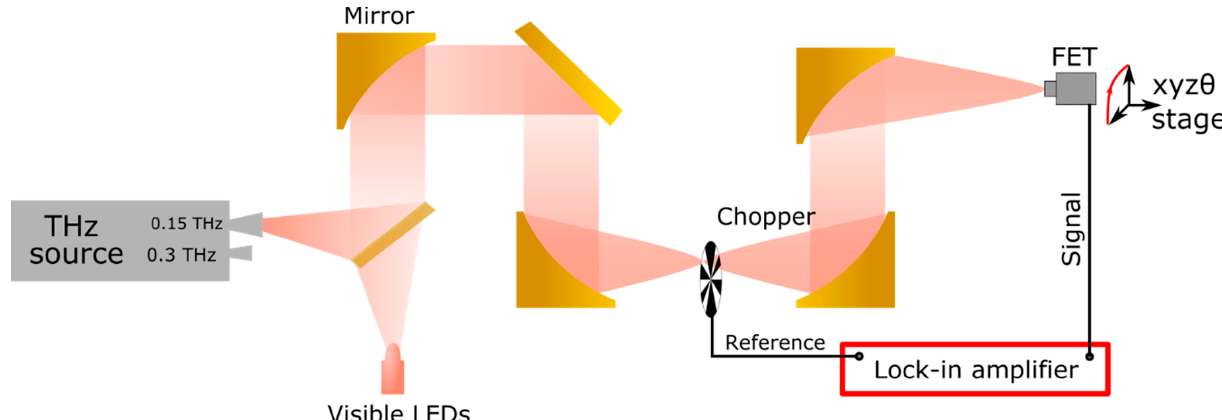
Figure 2. Schematics of the setup used in the sub-THz measurements: a solid-state source (at the left side of the figure) generates electromagnetic radiation at 0.15 and 0.3 THz that is detected by the strained-Si MODFET mounted on a XYZ θ stage (at the right side of the figure). The chopper and the lock-in amplifier used to detect the signal generated by the transistor under THz excitation are also shown.